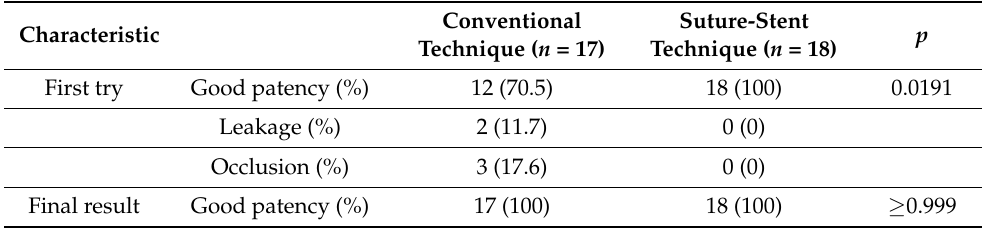
Table 3. Comparison of the anastomosis ICG findings after anastomosis between the conventional technique group and the suture-stent technique